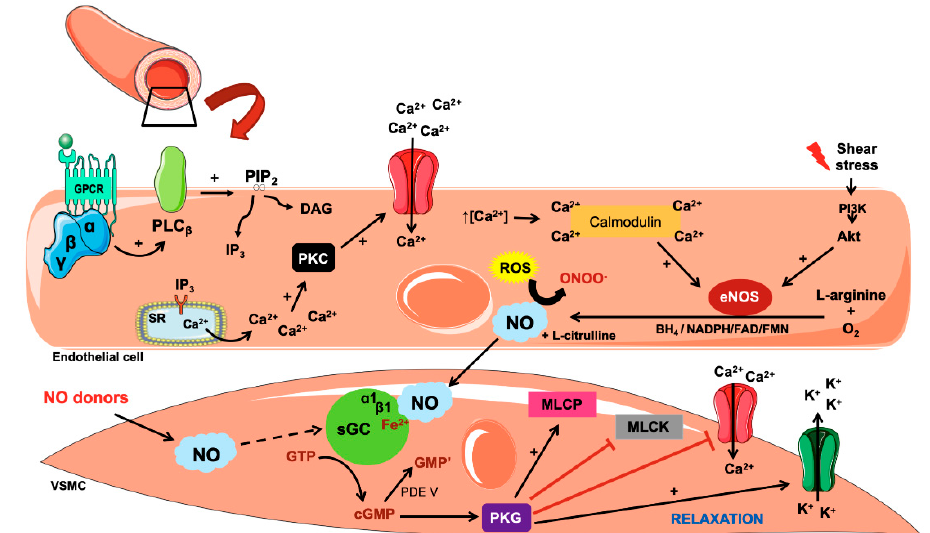
Figure 1. Nitric oxide (NO) induces relaxation in vascular smooth muscle cells (VSMC). The activation of G-protein coupled receptor (GPCR) stimulates phospholipase C (PLC), which is responsible for cleavage of membrane phospholipids to diacylglycerol (DAG) and inositol 1,4,5-trisphosphate (IP 3 ). The latter binds to the IP 3 receptor in sarcoplasmic reticulum (SR) to promote Ca 2+ extrusion, which, together with DAG, evokes Ca 2+ influx through voltage-operated Ca 2+ channels (Ca v ) at the cellular membrane. The linkage of Ca 2+ to calmodulin promotes endothelial nitric oxide synthase (eNOS) activation, which, in turn, triggers the formation of NO and citrulline from arginine and O 2 . This enzyme requires cofactors such as nicotinamide adenine dinucleotide phosphate (NADPH), flavin adenine dinucleotide (FAD), flavin mononucleotide (FMN), and tetrahydrobiopterin (BH 4 ). In case of an increase in reactive oxygen species (ROS), they react with NO and induce peroxynitrite (ONOO − ) production. NO spreads to VSMC where it binds to soluble guanylyl cyclase (sGC) and causes the formation of 3,5-cyclic guanosine monophosphate (cGMP), which stimulates the cGMP-protein kinase G (PKG). This kinase negatively regulates the Ca v and myosin light chain kinase (MLCK) and activates potassium channels and the myosin light chain phosphatase (MLCP). Altogether, these effects promote the relaxation of VSMC. In addition, NO can be produced from a GPCR-independent mechanism. The shear stress promotes activation of the PI 3 K/AKT pathway, which stimulates eNOS activation and subsequent NO